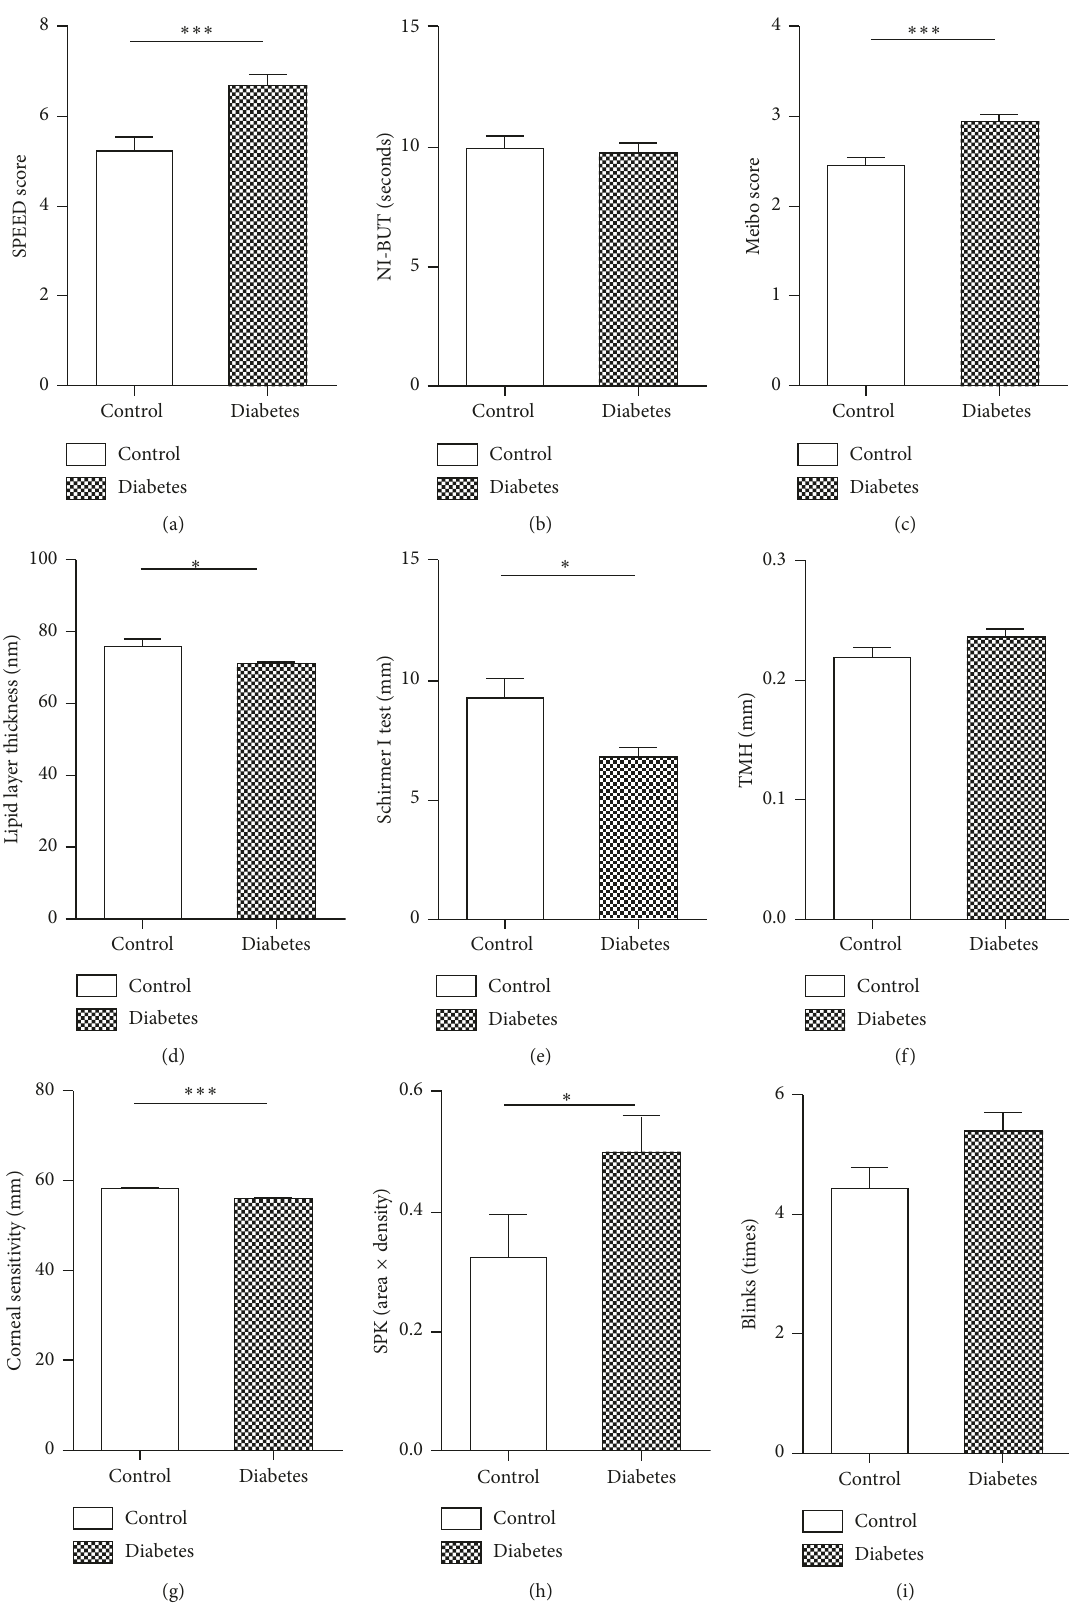
Figure 1: Comparison of ocular surface parameters between diabetic patients and healthy controls. The SPEED score (a), meiboscore (c), lipid layer thickness values (d), Schirmer I results (e), corneal sensitivity (g), and SPK score (h) were significantly different between the diabetic and the healthy control group. The differences in NI-BUT (b), TMH (f), and blinks (i) did not reach statistical significance between the diabetic and control groups ( ∗ P < 0 . 05, ∗∗ P < 0 . 01, and ∗∗∗ P ≤ 0 .